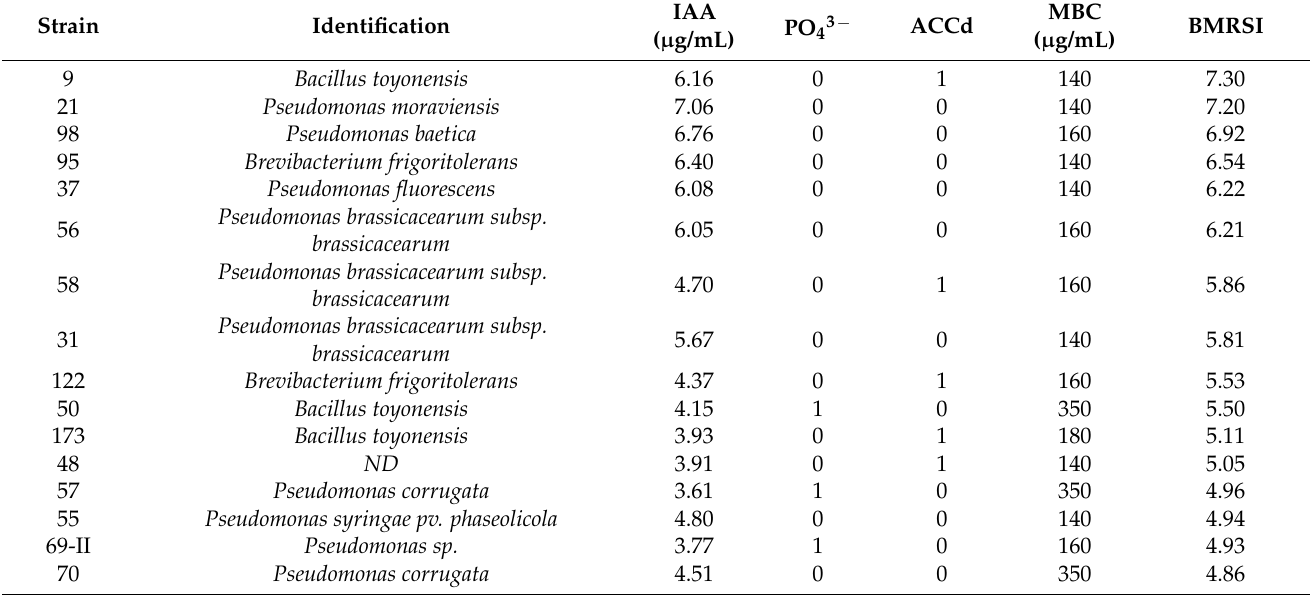
Table 2. Strains ordered by BMRSI descending values with all factors integrated, IAA: IAA production; PO 43 − : solubilization of phosphates; ACCd: degradation of ACC via ACC deaminase; MBC: maximum bactericidal concentration. 0/1 indicates absence/presence. ND: not defined